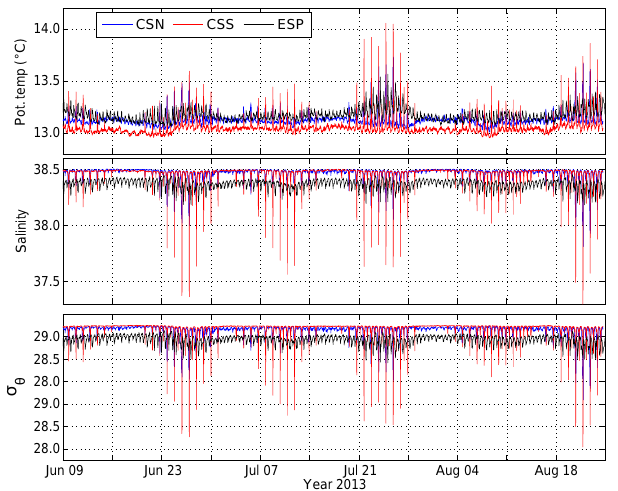
Figure 3. Mean σ θ values at CSN (blue circles) and at CSS (red squares) and standard deviation (bars) of all observations grouped in 1h length bins. The curve refers to the sea level oscillation at Tarifa (see Fig. 1 for location) and HW stands for high water. The first bin includes all samples collected between HW and HW + 1h regardless the date, the second one the samples between HW + 1 and HW + 2, and so on. The highest σθ values (which also have minimum SD) are regularly observed near HW, whereas the lowest values spread around low water and show a marked